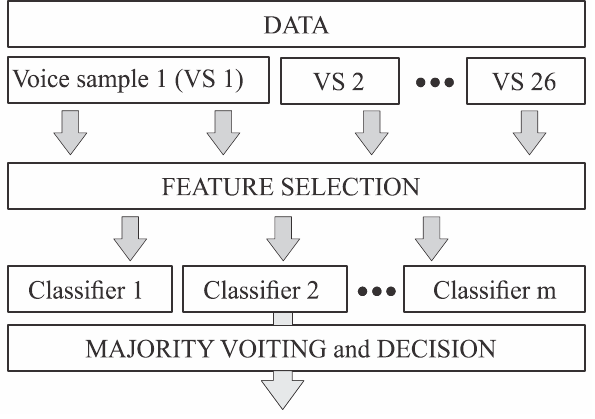
Figure 1. Block diagram of the proposed method.